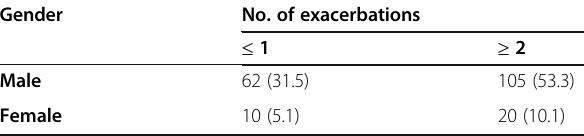
Table 4 Distribution of age with gender